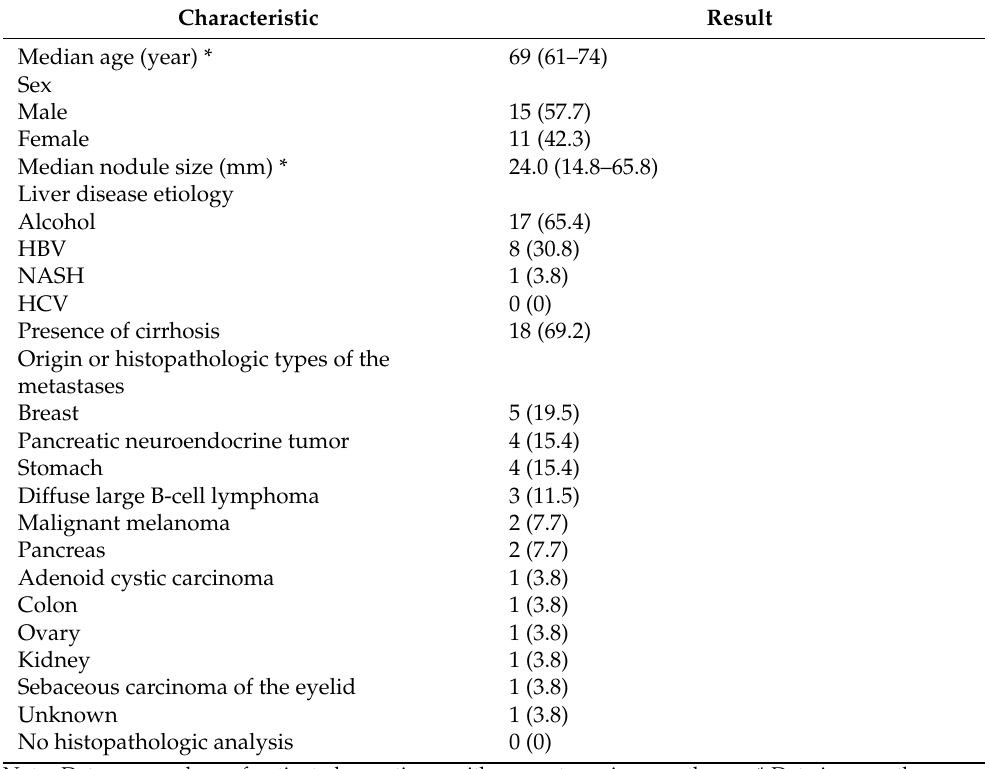
Table 2. Clinical and histopathologic data of liver metastases ( n = 26).